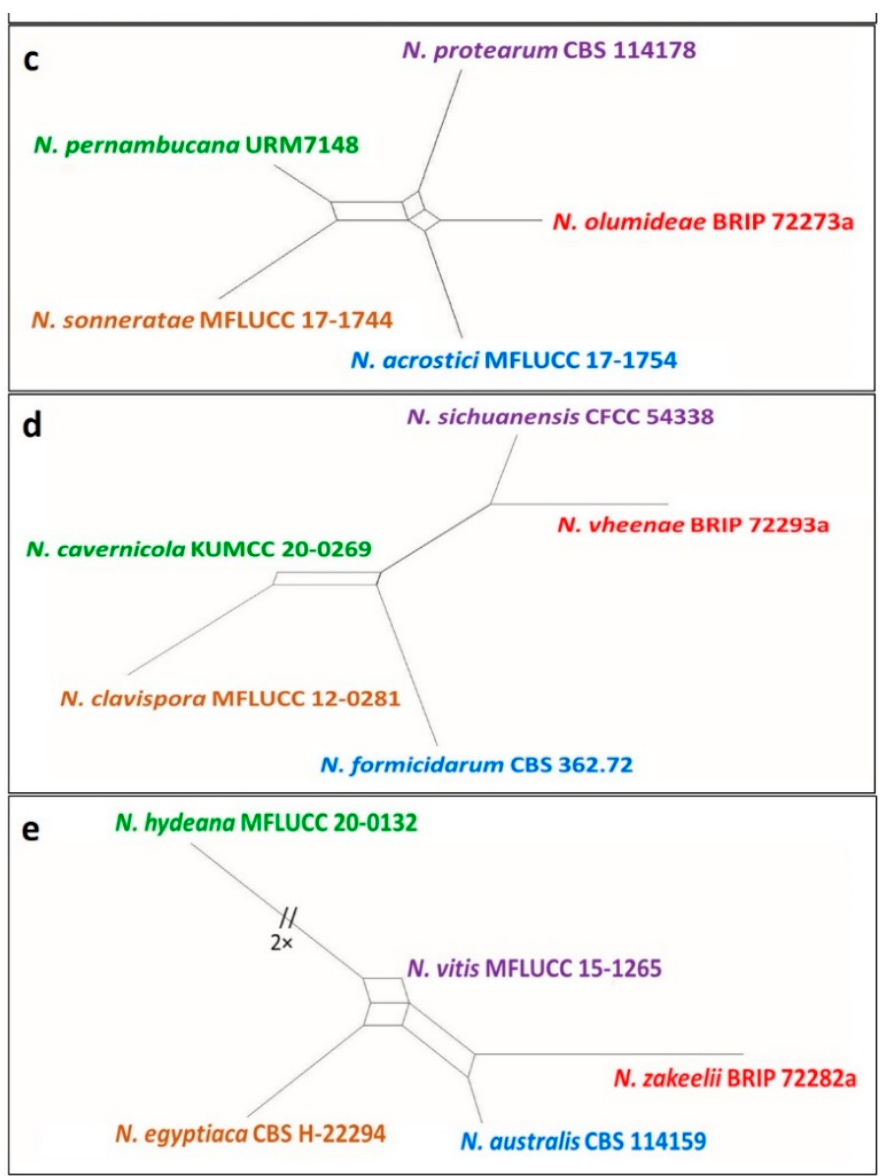
Figure 8. Split graphs showing the result of PHI test of ( a ) Neopestalotiopsis drenthii (Fw = 0.735), ( b ) N. maddoxii (Fw = 0.118), ( c ) N. olumideae (Fw = 0.581), ( d ) N. vheenae (Fw = 0.876), and ( e ) N. zakeelii (Fw = 0.412) with their most closely related species using Log-Det transformation and splits decom- position options. The new taxon in each graph is shown in red font.